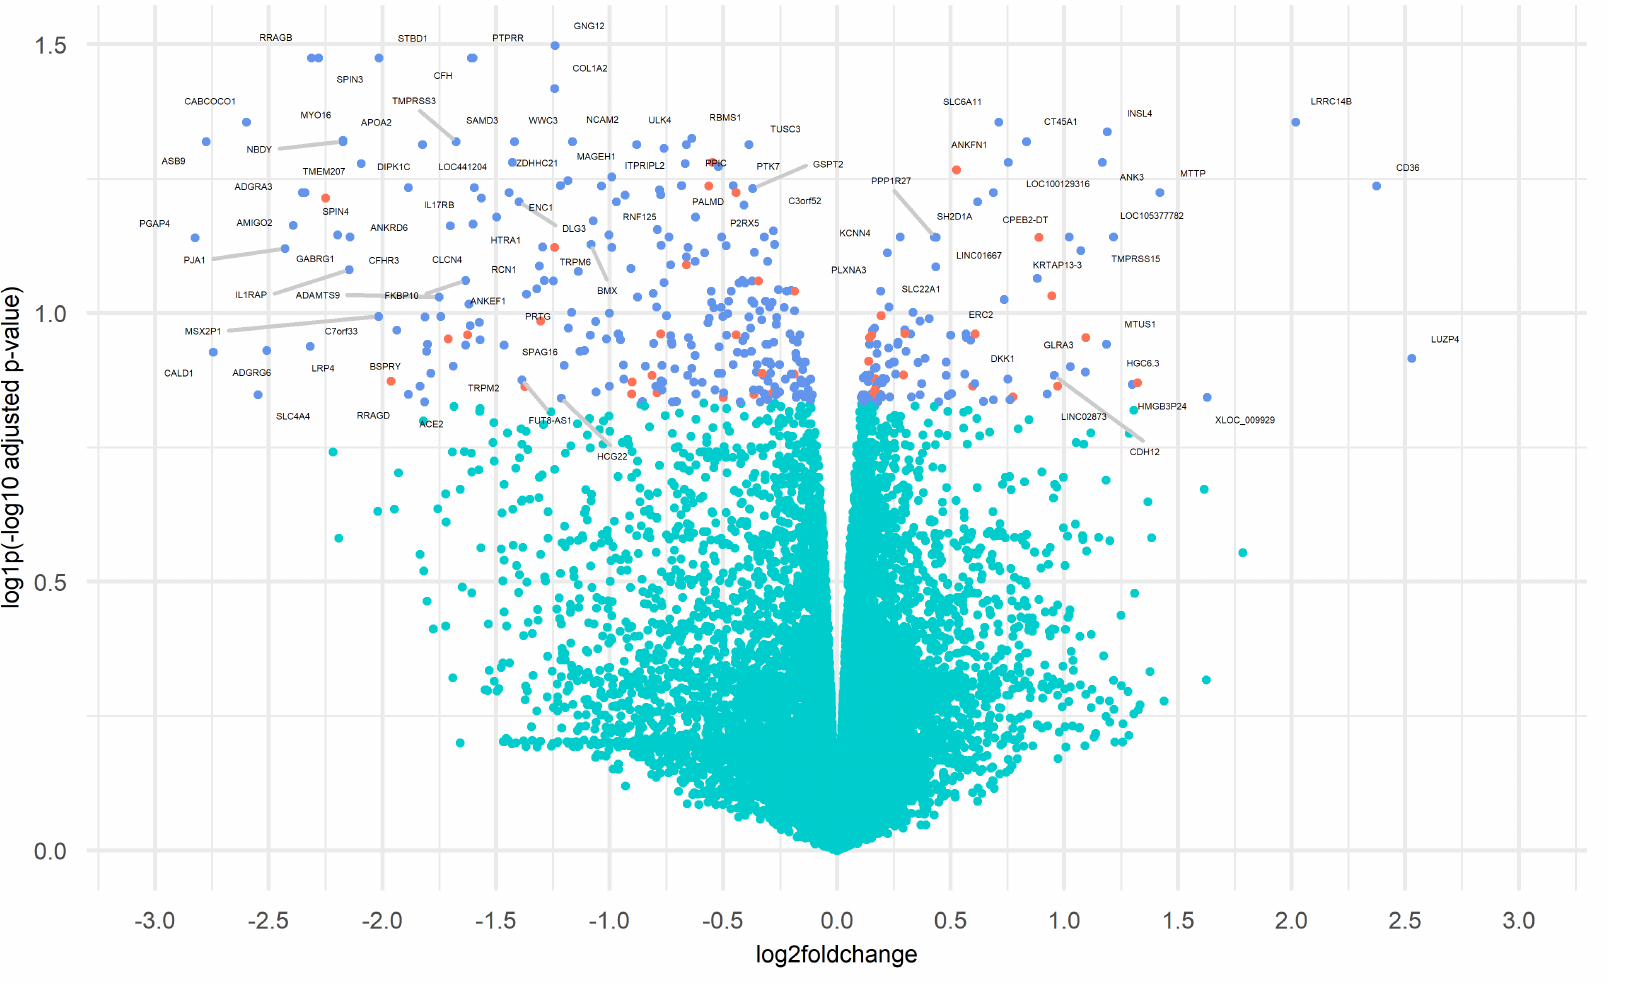
Figure 2. Volcano plot plot for DEGs among controls and PTPRG overexpressing K562. Genes are represented as scattered points: the x -axis is the log2FoldChange, and the y -axis shows the log1p(-log10 adjusted p -value). Green dots represent the non-differentially expressed genes. Both red and blue dots represent genes that were identified as significantly differentially expressed (adjusted p -value < 0.05) with | log2FoldChange | > 0.1. Specifically, red dots refer to transcription